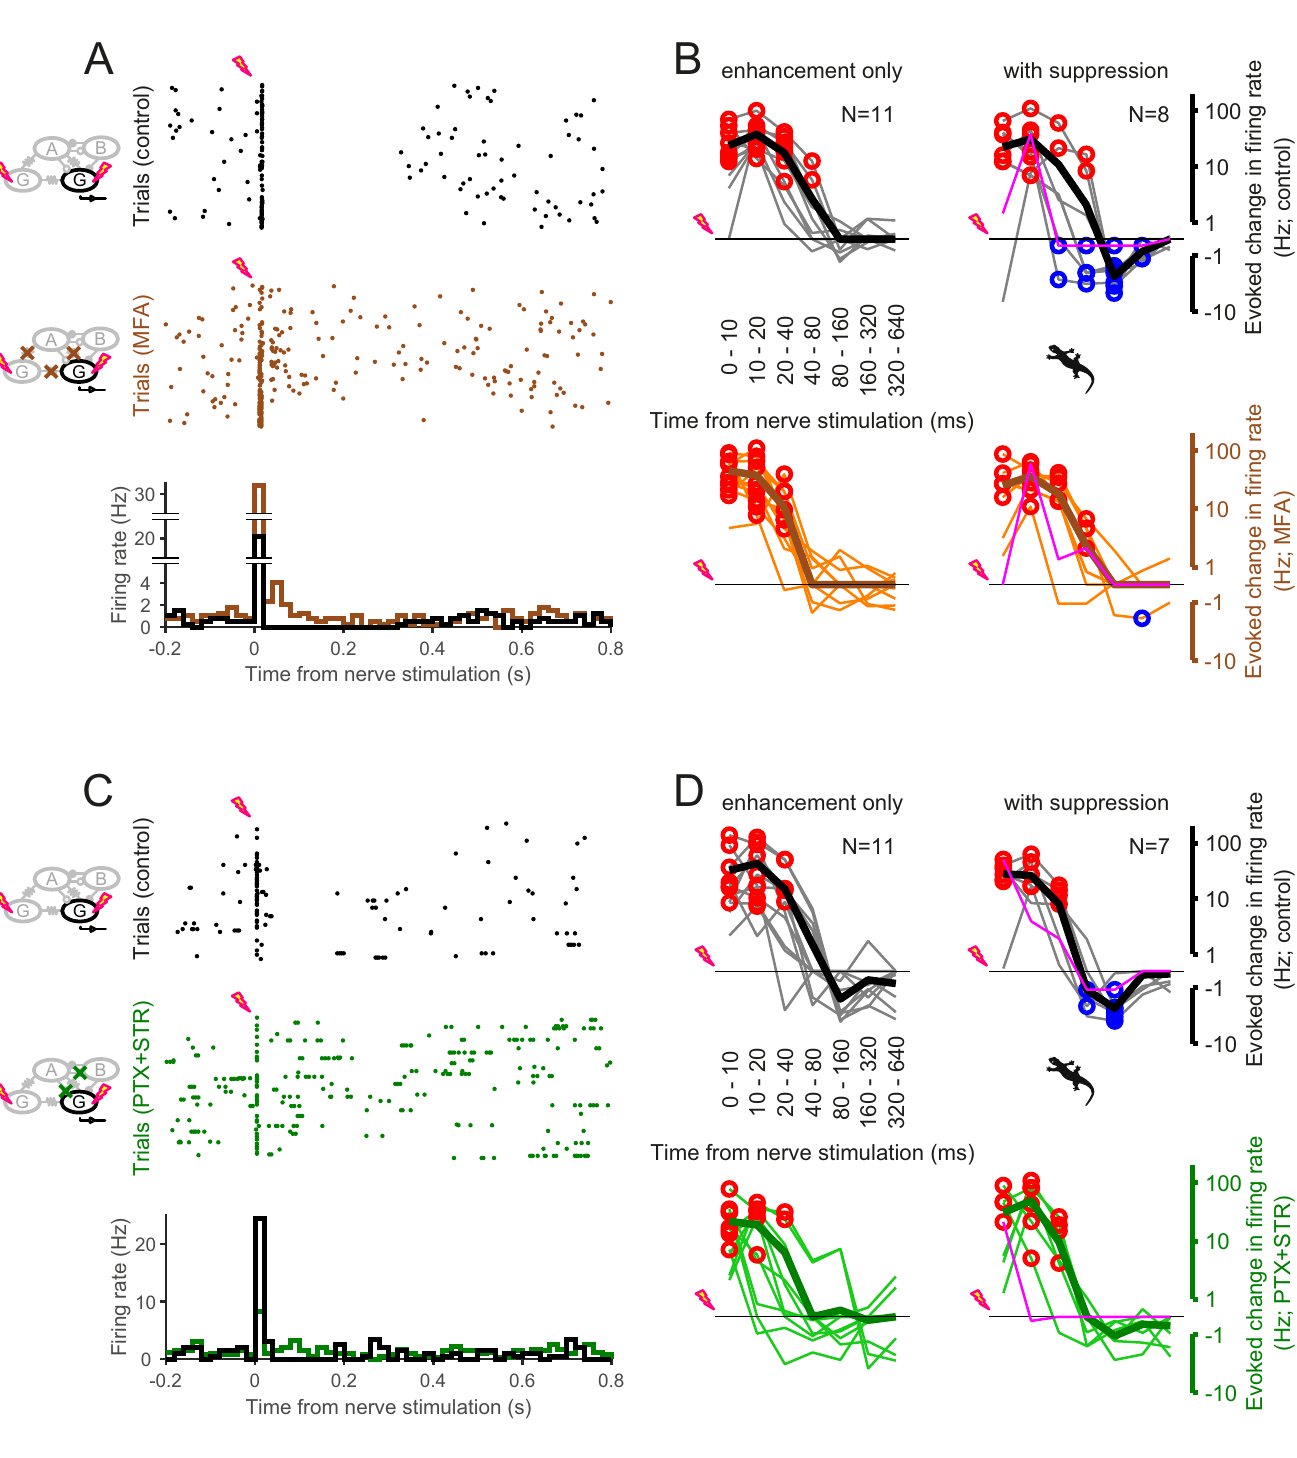
Fig 6. Negative feedback involves electrical synapses and inhibitory synaptic transmission. (A) Spiking activity of a salamander retinal ganglion cell in the dark (top, raster graphs; bottom, PSTHs) in response to the optic nerve stimulation in the absence (black; control) and presence (brown) of gap junction blockers (100 μ M meclofenamic acid; MFA). (B) Summary of the effects of blocking gap junctions on the ganglion cell firing patterns after the nerve stimulation (top, control; bottom,